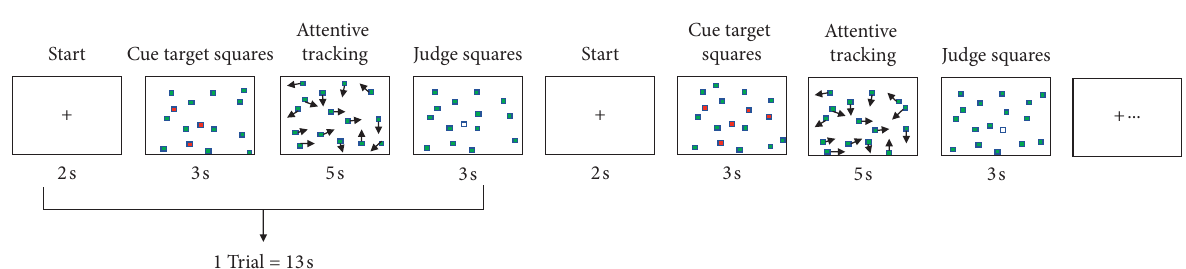
Figure 1: Illustration of the 2-back task.